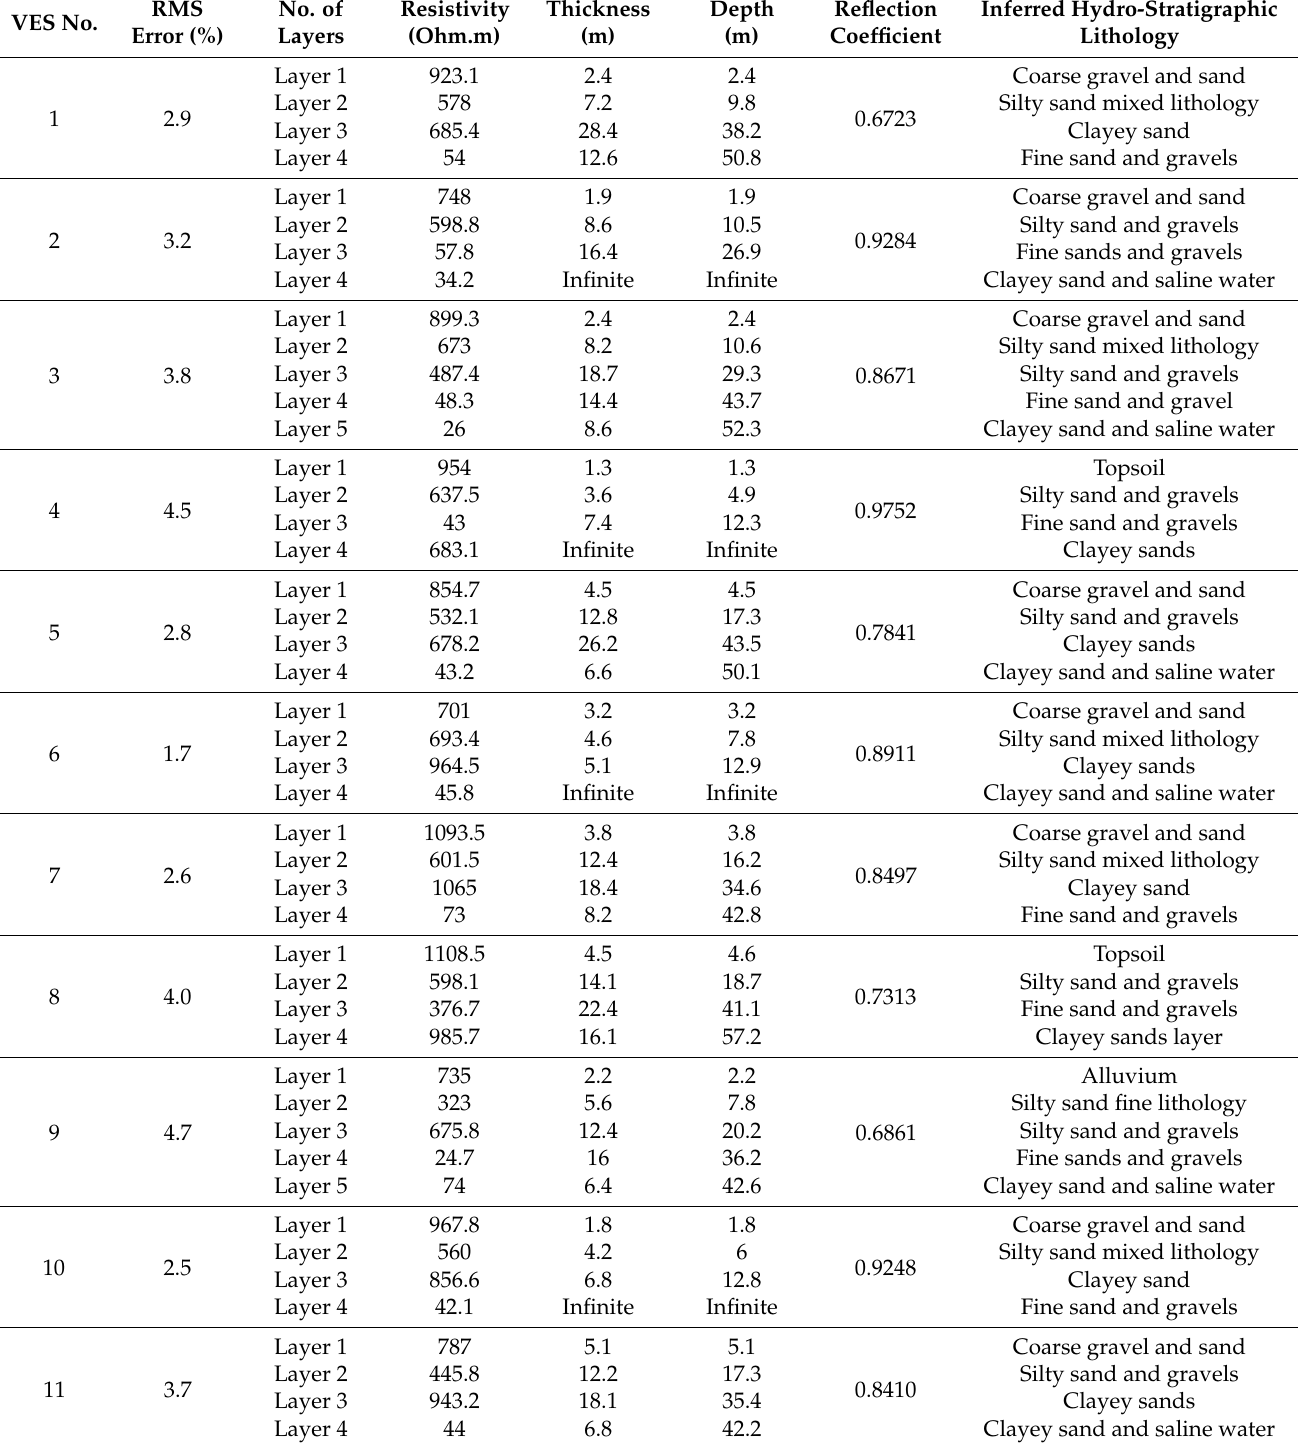
Table A1. Summary results of VES data interpretation demonstrate the inferred lithologies corresponding to resistivity variation and hydrogeologic layers. VES